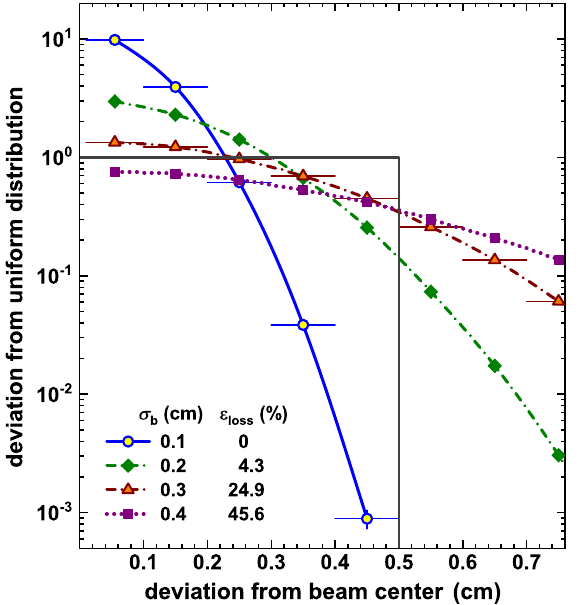
1. The ratios of the beam densities according to Eq. (1) at different σ b values and respective values for the uniform distribution as obtained with Monte Carlo simulations. Horizon- tal bars for σ b ¼ 0 . 1 and 0.3 cm correspond to the widths